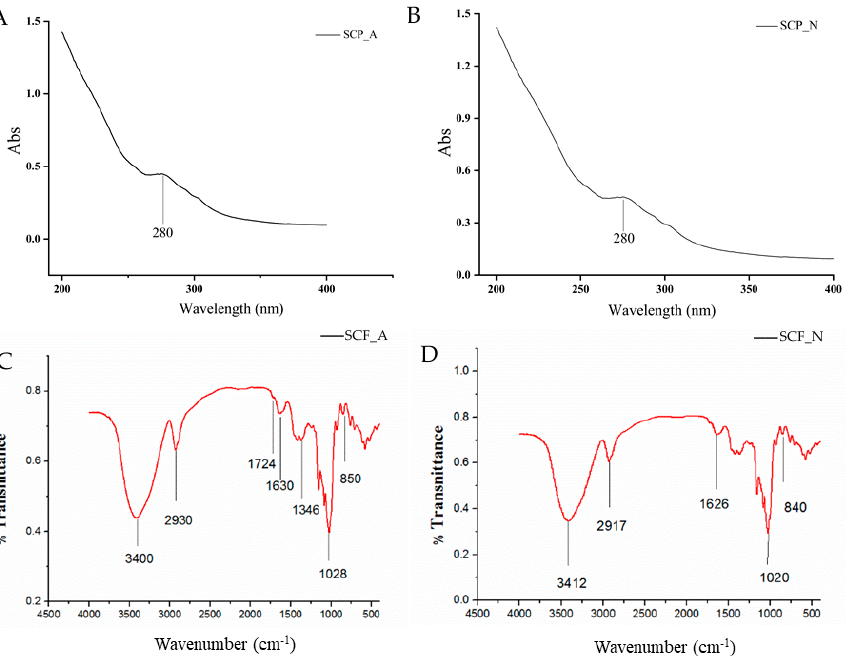
Figure 1. Spectrum of Smilax china L. polysaccharide. ( A ) UV spectrum of SCP_A; ( B ) UV spectrum of SCP_N; ( C ) FT-IR spectra of SCF_A; ( D ) FT-IR spectra of SCF_N.